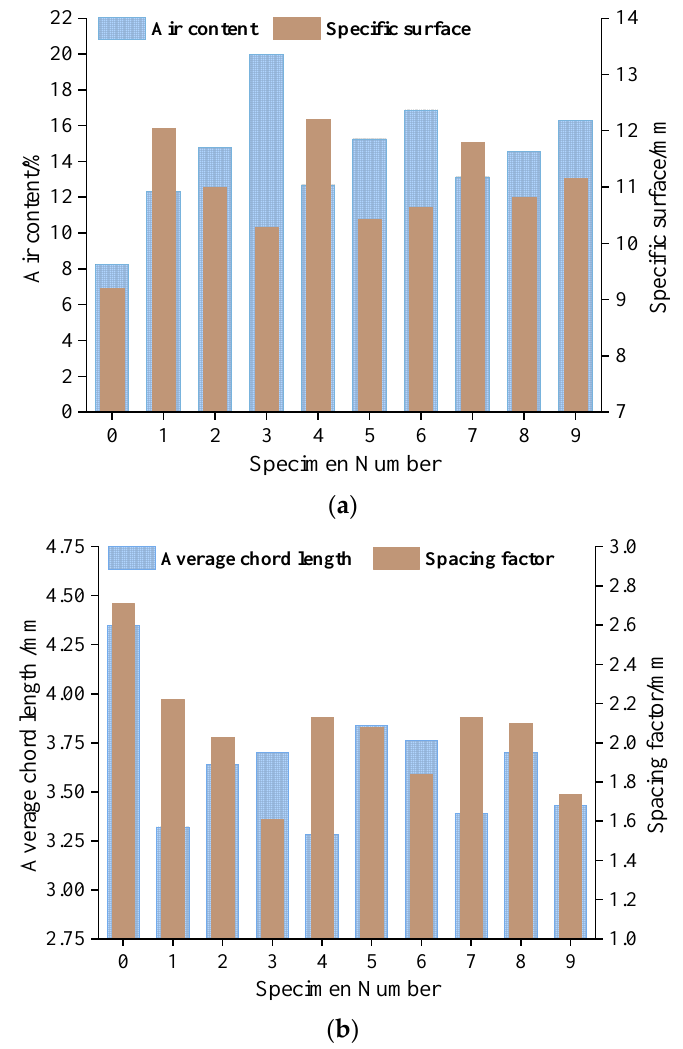
Figure 12. The pore structure parameters. ( a ) air content and specific surface; ( b ) average chord length and spacing factor.